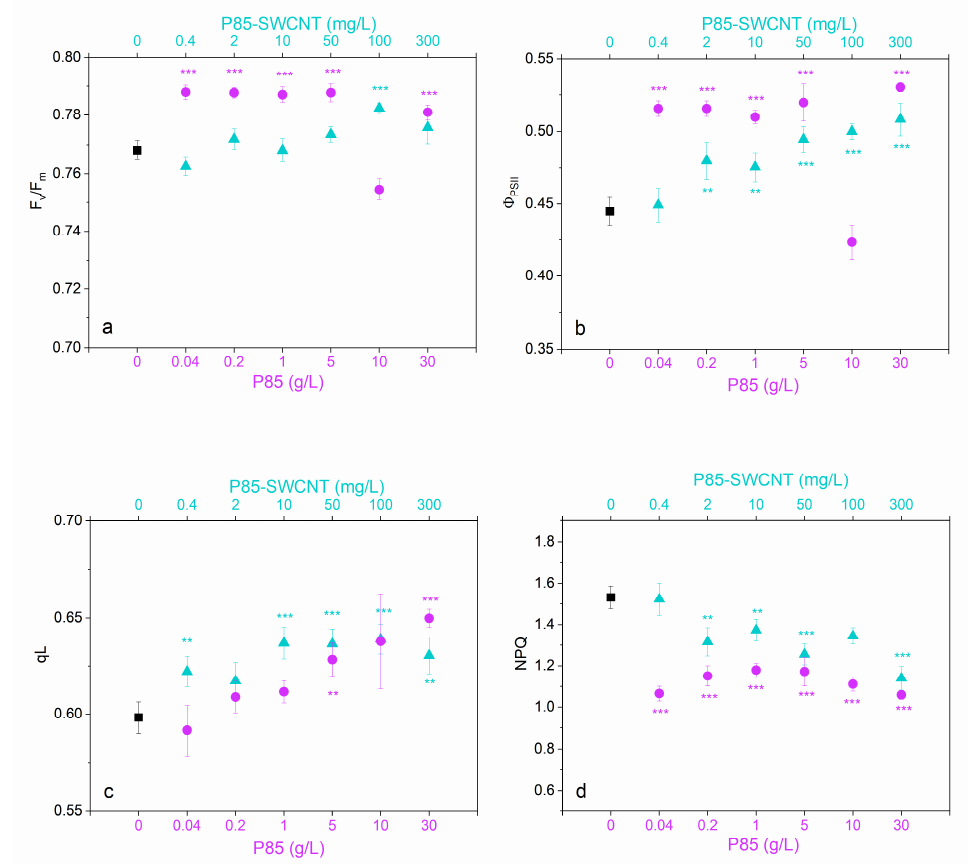
Figure 4. Chlorophyll fluorescence parameters determined on intact leaves of 14-day-old plants developed from hydro-, P85-SWCNT-, and P85-primed seeds. Maximum quantum yield of photosystem II in the dark (F v /F m , ( a )), quantum efficiency of PSII photochemistry in the light ( Φ PSII , ( b )), fraction of open PSII reaction centers (qL, ( c )), and non-photochemical quenching of Chl a fluorescence determined after 15 min of illumination (NPQ, ( d )). Mean ± SE. Statistically significant differences from the control sample at p < 0.05 (**), p < 0.01 (***) according to Student’s t -test are indicated with the respective colors (violet for P85 and cyan for P85-SWCNT treatments).